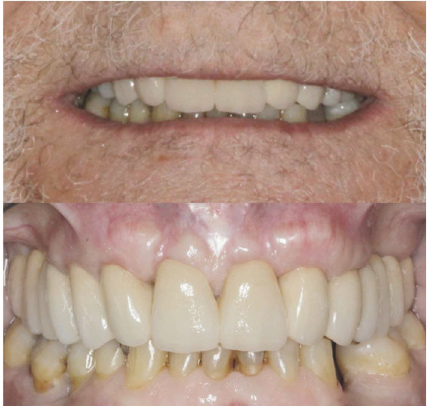
Figure 10: Extraoral and intraoral views of the fi nal restoration after the 1-year follow-up.